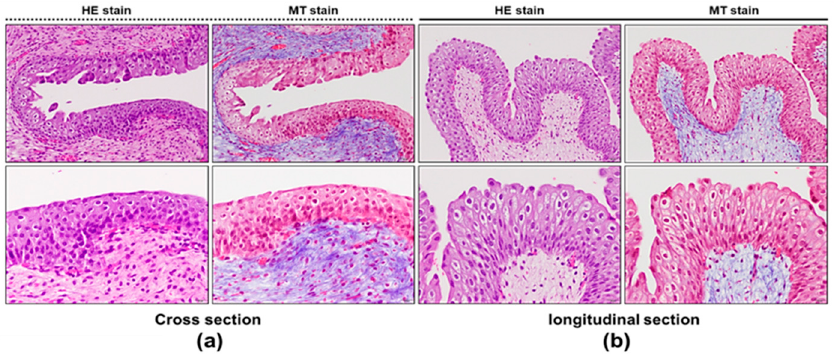
Figure 7. Histological findings of the rabbit bladder at 7 days after implantation. ( a ) Cross and ( b ) longitudinal sections of a representative mucosal layer of the bladder stained with hematoxylin and eosin (H&E) and Masson’s trichrome (MT) (magnification, 100 × and 200 × ).